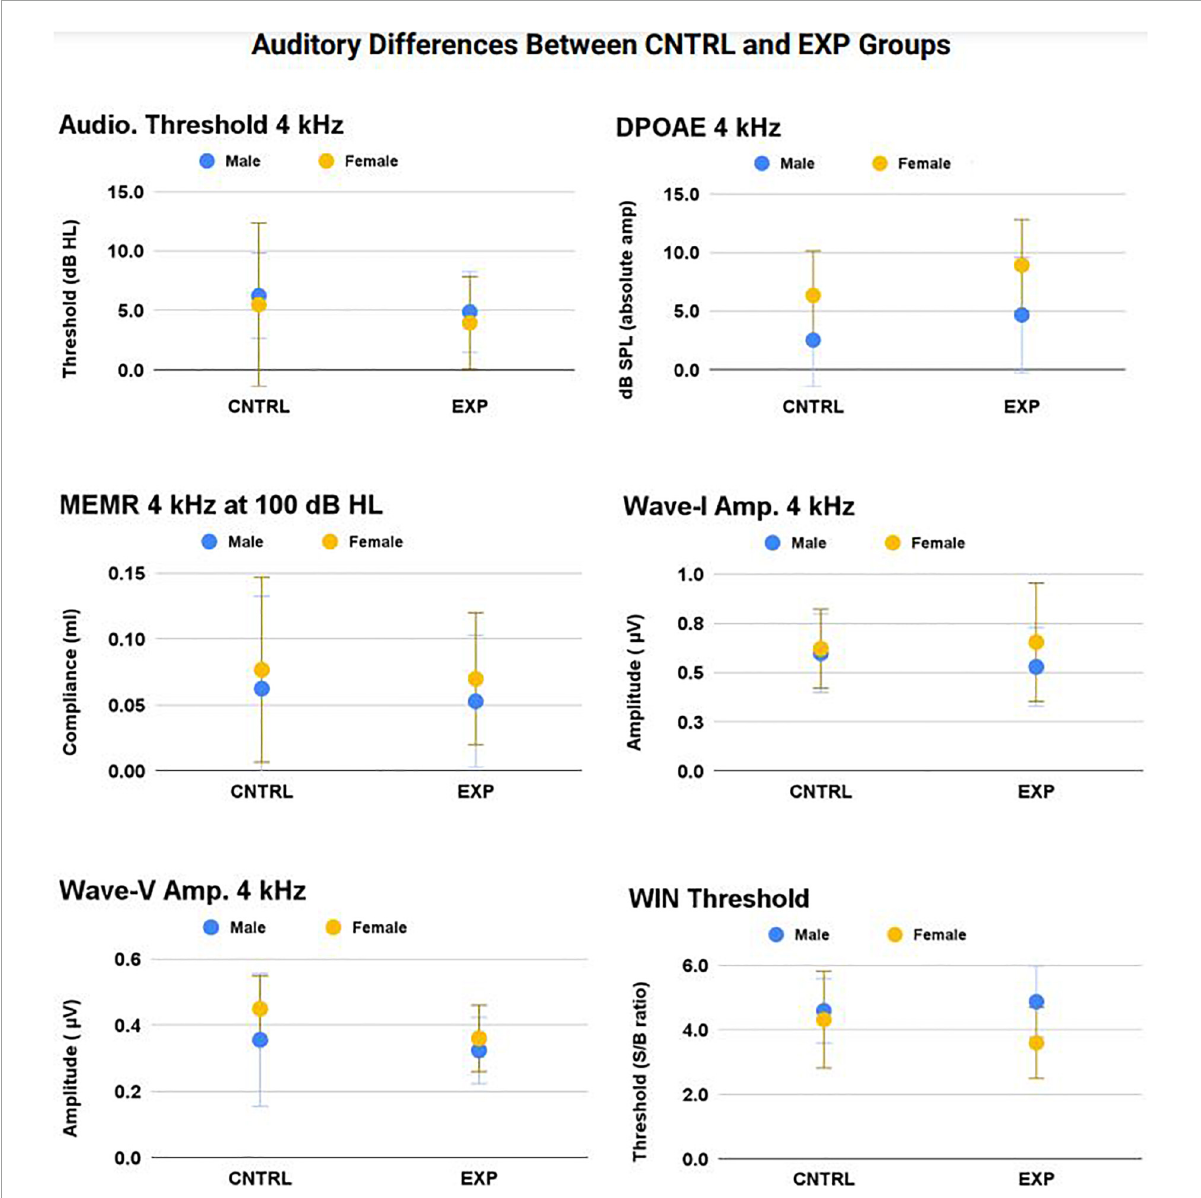
FIGURE6 No statistically significant main effect nor interaction effect of firearm group was observed on audiologic outcomes ( p > 0.05). The frequency at which noise-induced deficits were most likely to be observed between groups — 4 kHz — is shown here (mean ± 1SD) for audiometric threshold, DPOAE, MEMR, ABR Wave-I amplitude, ABR Wave-V amplitude, and WIN threshold (all p’s >